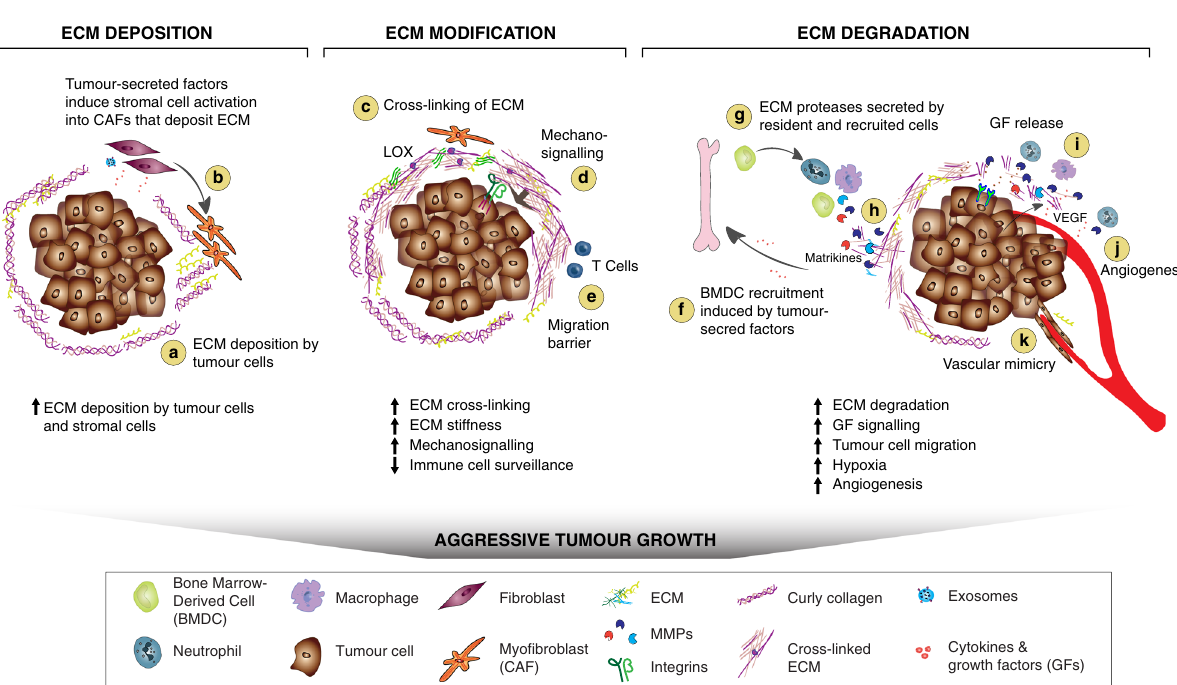
Fig. 2 ECM remodelling in the primary tumour. a , b Tumour-derived factors activate stromal cells which differentiate into cancer-associated fi broblasts (CAFs) leading to the secretion and deposition of large amounts of ECM components along with the cancer cells. c ECM-modifying enzymes such as LOX expressed by tumour cells and CAFs cross-link and align collagen fi bres, which increases matrix stiffness around the tumour, and e the formation of a physical barrier to evade immune surveillance by T-cells. d Increased matrix stiffness promotes the interaction between ECM components and cell-surface receptors on tumour cells that triggers mechanosignalling mediated by integrins. f To sustain a tumourigenic microenvironment, tumour cells and resident immune cells secrete cytokines, chemokines and growth factors (GFs), which differentiate and recruit bone marrow-derived cells (BMDCs). g The BMDCs, CAFs and tumour cells secrete ECM-degrading proteases, including MMPs, which are cell surface-bound (e.g., MT1-MMP) or secreted (e.g.,